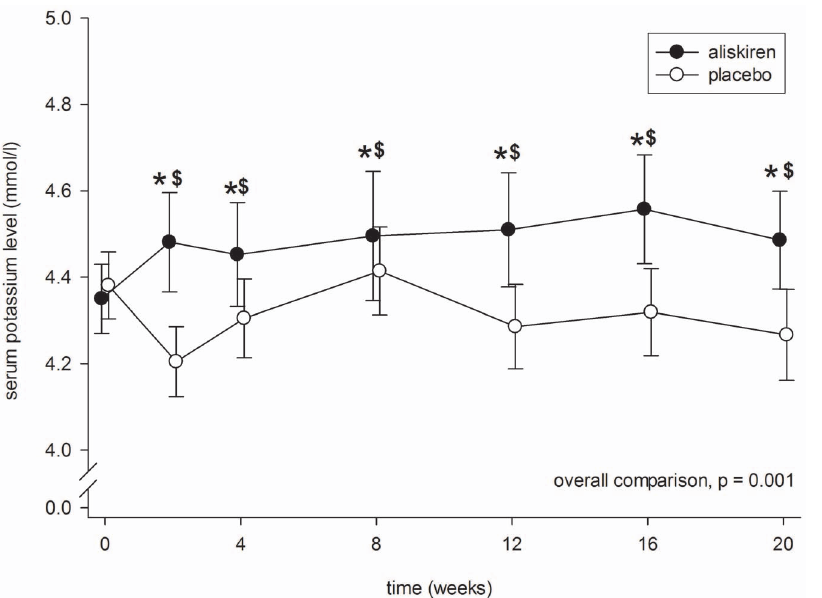
Figure 6. Serial change in serum potassium level during the periods of aliskiren (closed circles) and placebo (open circles) treatment. Error bars denote standard error of mean. Post-hoc comparisons were performed by paired Student’s t test: *p , 0.001 as compared to baseline level; $ p , 0.001 as compared to the period of placebo treatment. All P values were computed with Bonferroni adjustment for multiple comparisons.